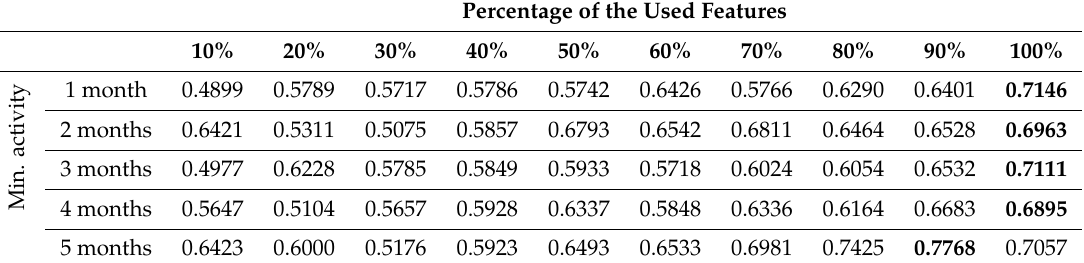
Table A2. F-score macro average for the Random Forest classification of two levels of the hierarchy in the manufacturing company dataset. The values which are bolded are the best results for a given minimum communication activity.